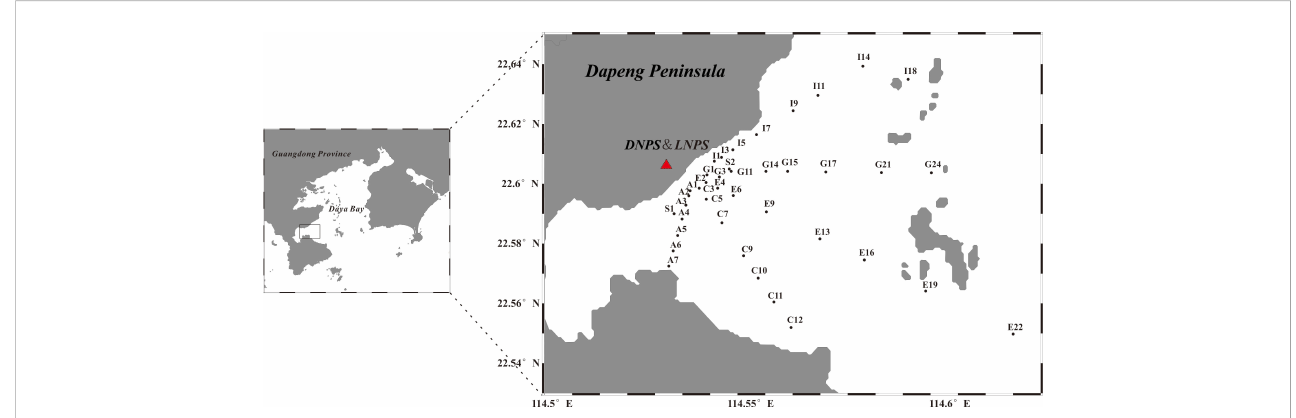
FIGURE 1 Sampling stations near the nuclear power plant area. The red triangles indicate the location of the Daya Bay nuclear power station (DNPS) and Ling-ao nuclear power station (LNPS). Transects A-I were only surveyed in the morning, while S1 and S2 were sites for diurnal investigation at control and outlet